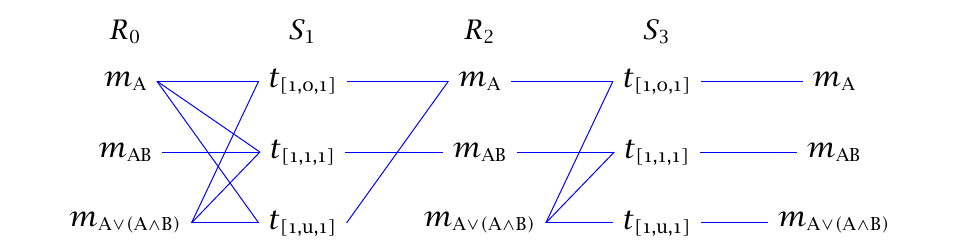
Figure 16 Predictions for interpretation of “ A or ( A and B )” under a